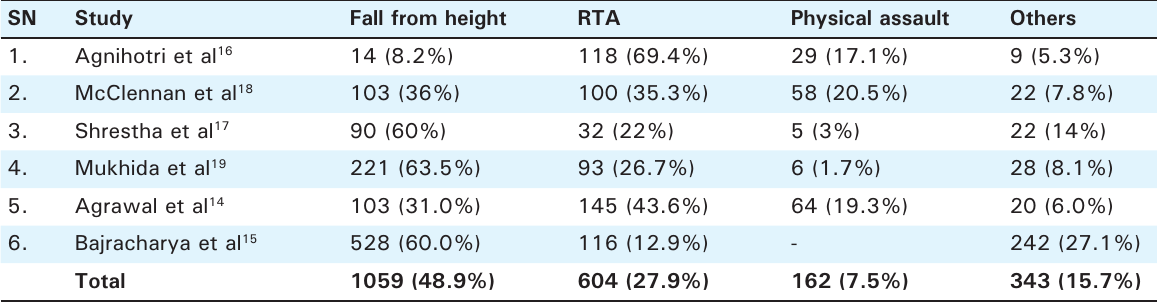
Table 7. Causes of